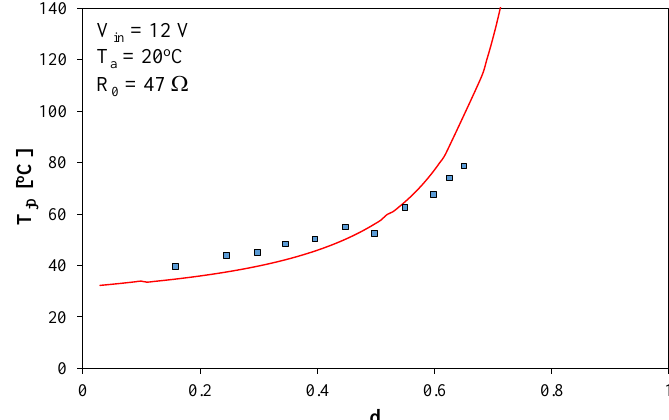
Energies 2020 , 13 , x FOR PEER REVIEW Figure 14. Computed and measured dependences of internal temperature of IGBT on duty cycle.